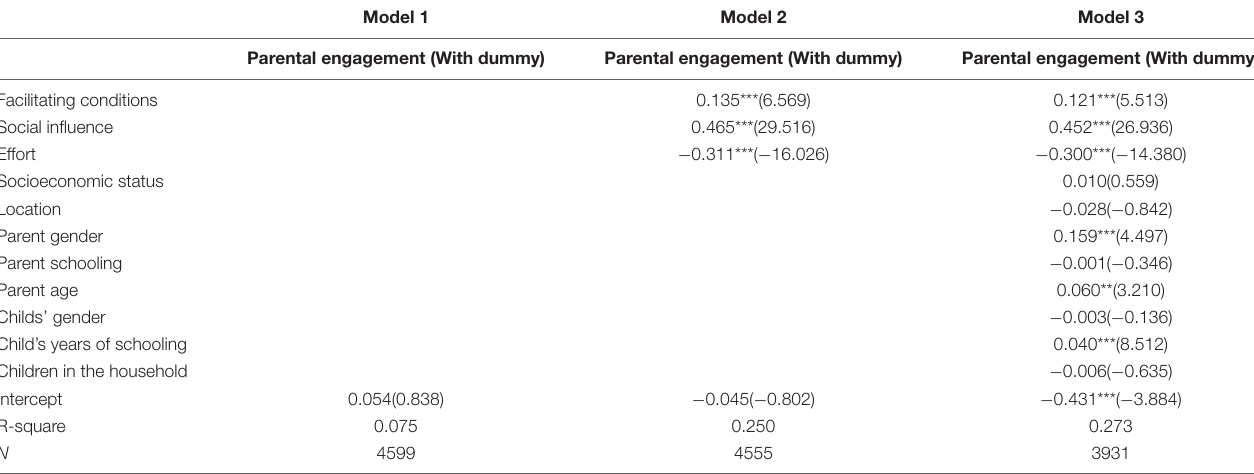
TABLE 5 | Parents’ acceptance and use of technology predicting parental engagement with children’s